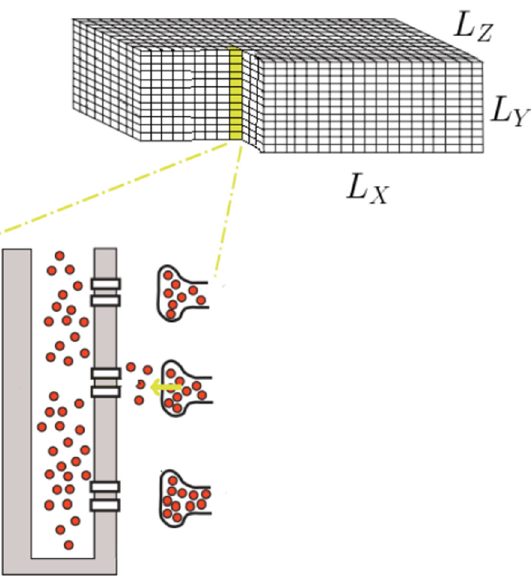
Figure 1. A schematic diagram of ventricular myocytes modeled as a rectangular